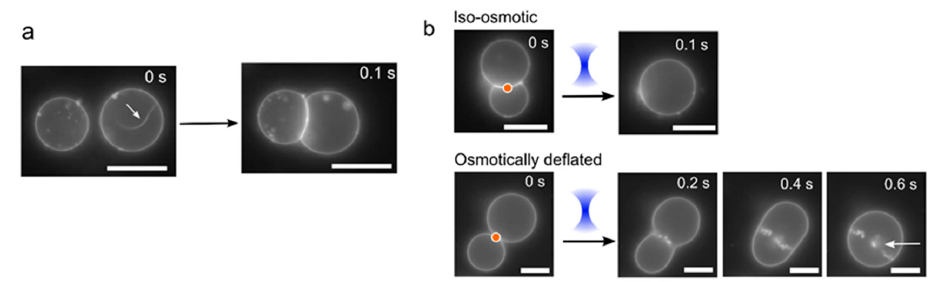
Figure 4. Vesicle morphology changes under di ff erent osmotic conditions. ( a ) If vesicles have excess membrane area and low tension, they may contain tubules (white arrow). Upon adhesion, the vesicle deform to a non-spherical geometry, which increases its tension and leads to a retraction of the tubule into the main vesicle body. ( b ) Images showing post-fusion morphologies under iso-osmotic (0.75 M sucrose internally; 0.35 M glucose, 0.2 M NaCl externally) and osmotically deflated (0.75 M sucrose internally; 0.4 M glucose, 0.2 M NaCl externally; low tension) conditions. In the former, a clean-merge is seen; in the latter the vesicle slowly relaxes to a spherical shape and many smaller internal vesicles are produced and retained inside (white arrow). Orange dot corresponds to area of laser focus. Scale bars = 5 µ